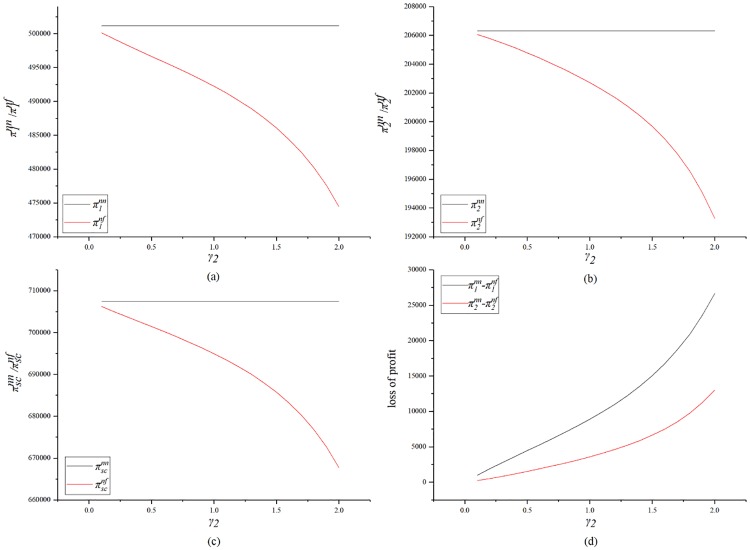
Impact of γ2 on the profits.